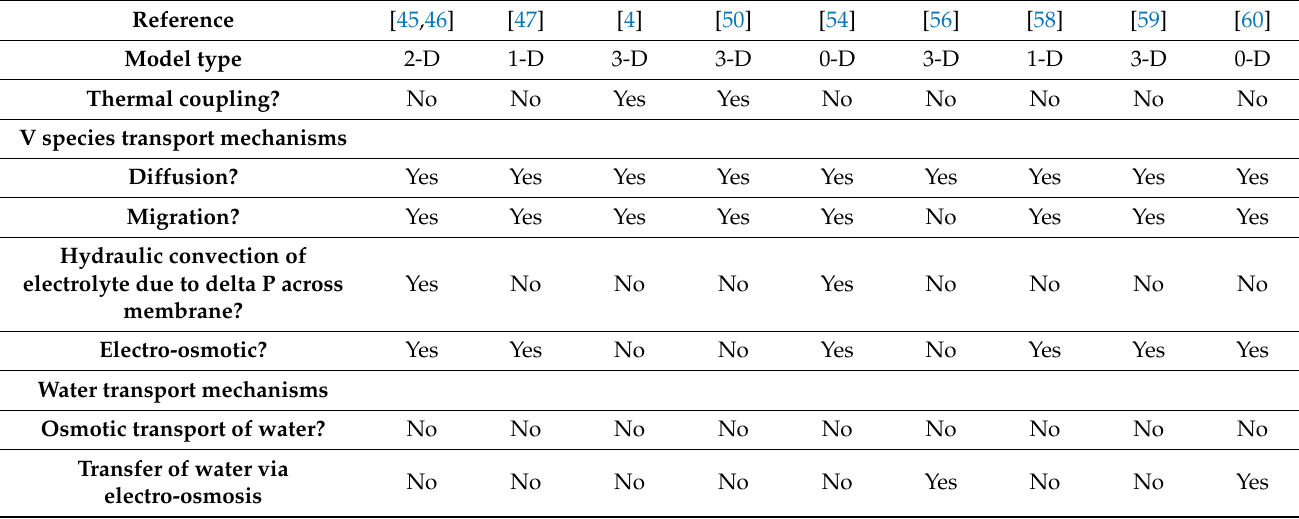
Table 2. Summary of models of species crossover in